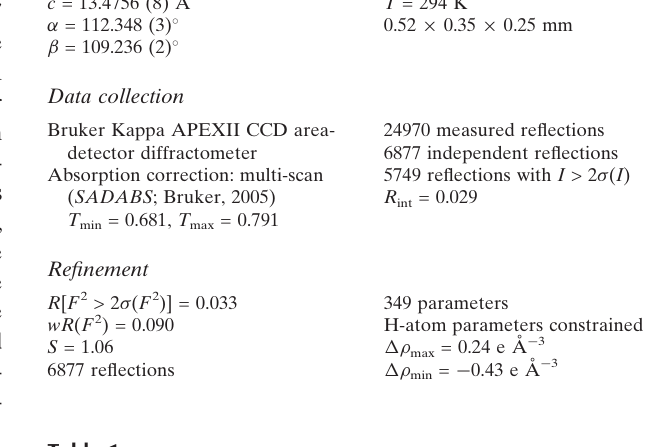
Bruker Kappa APEXII CCD area- detector diffractometer